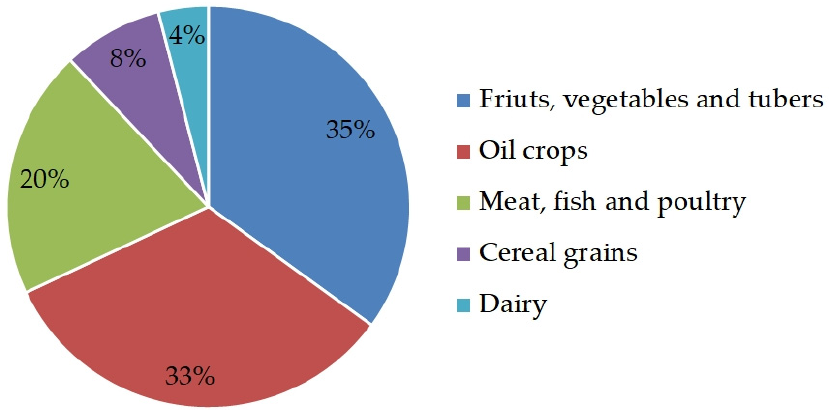
Figure 1. Estimation of food waste produced per sub-sectors at the processing stage in Europe (adapted from Rao, Bastand de Boer [4]).